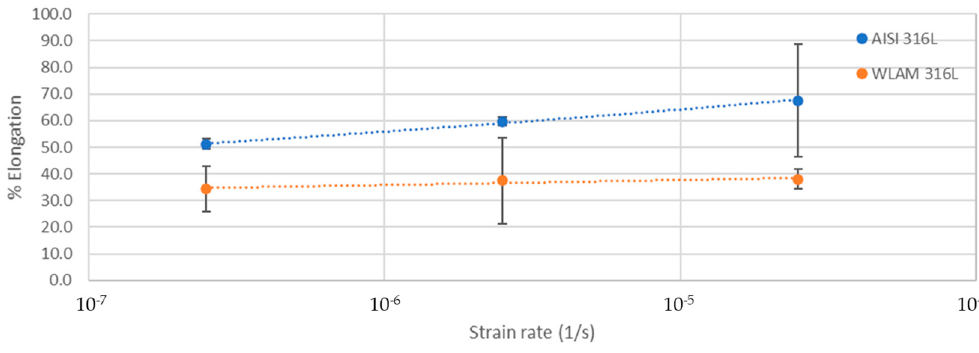
Figure 9. Elongation vs. strain rate of the WLAM samples and the counterpart AISI 316L alloy.